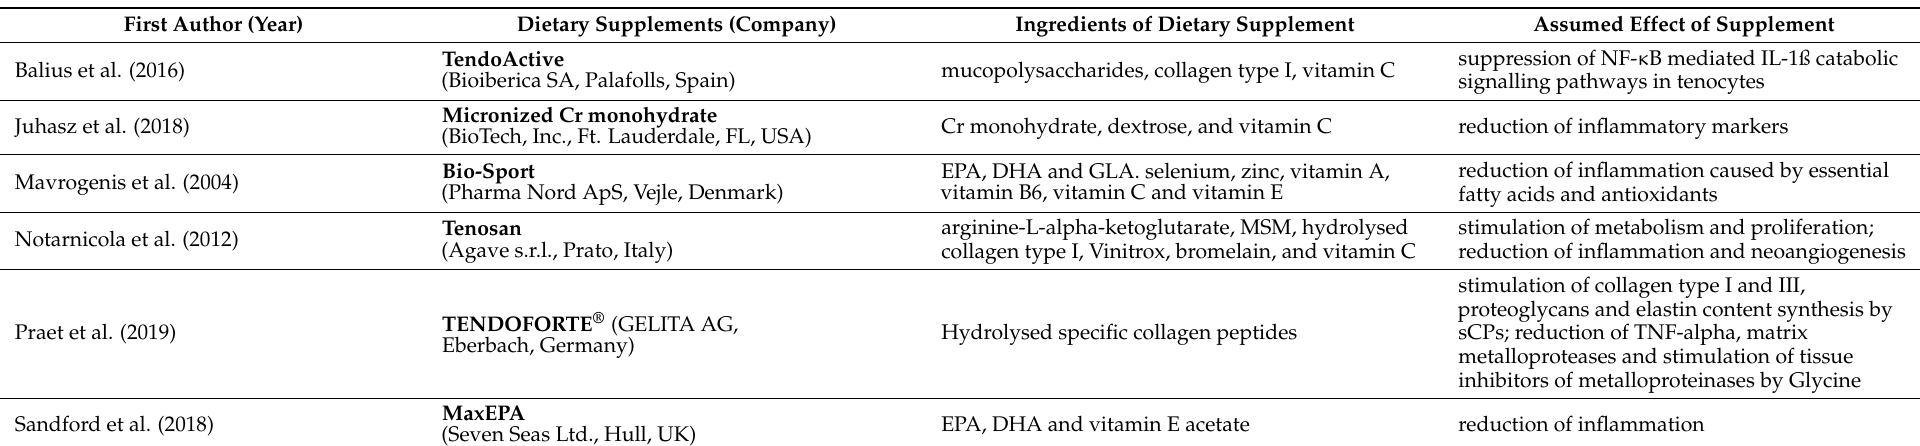
Table 2. Details of dietary